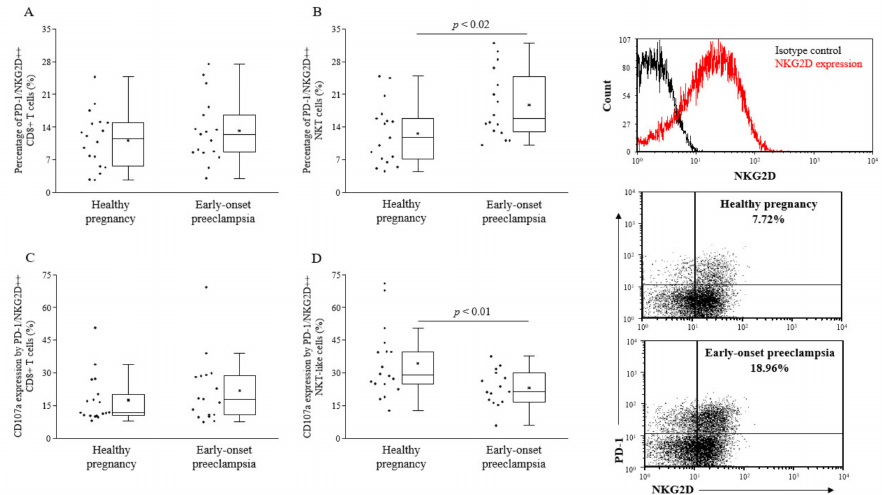
Figure 4. Percentage and cytotoxicity of PD-1/NKG2D double positive peripheral CD8+ T ( C ) and NKT-like cells ( D ) in 3rd-trimester healthy pregnant women and in women with early-onset preeclampsia. The percentage of PD-1/NKG2D double positive, CD8+ T cells ( A ), and NKT-like cells ( B ) in peripheral blood of women with early-onset preeclampsia and in healthy pregnant women. The solid bars represent medians of 17 and 17 determinations, respectively, the boxes indicate the interquartile ranges, and the lines show the most extreme observations. Differences were considered statistically significant for p -values ≤ 0.05.